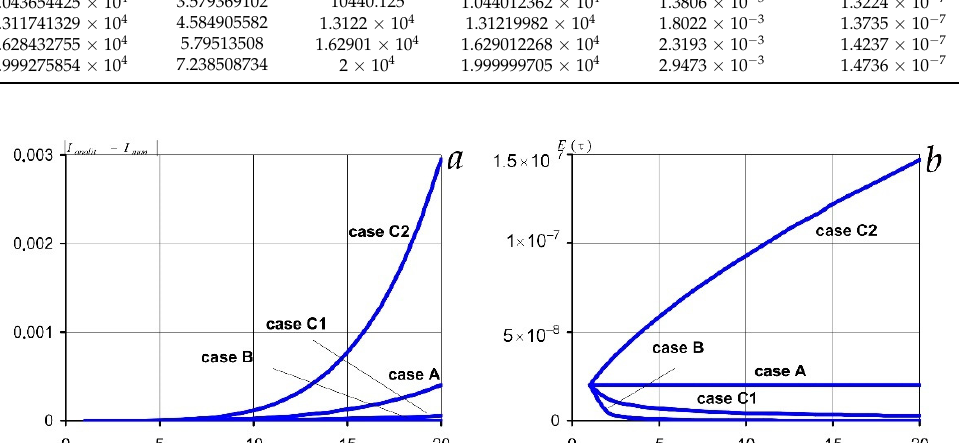
Figure 7. Graphs of absolute ( a ) and relative ( b ) errors for four considered cases, A, B, C1, and C2, of the relation between the number of nodes and grid width for the integrand f ( τ (cid:48) , τ (cid:48)(cid:48) ) = τ (cid:48) τ (cid:48)(cid:48)